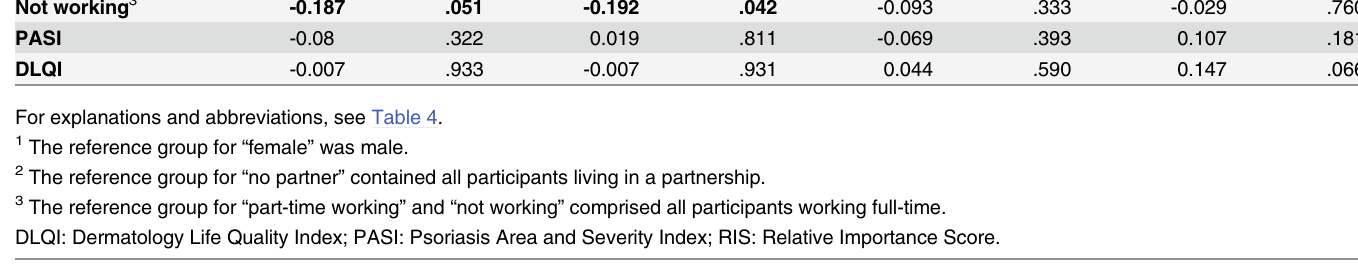
Process attributes